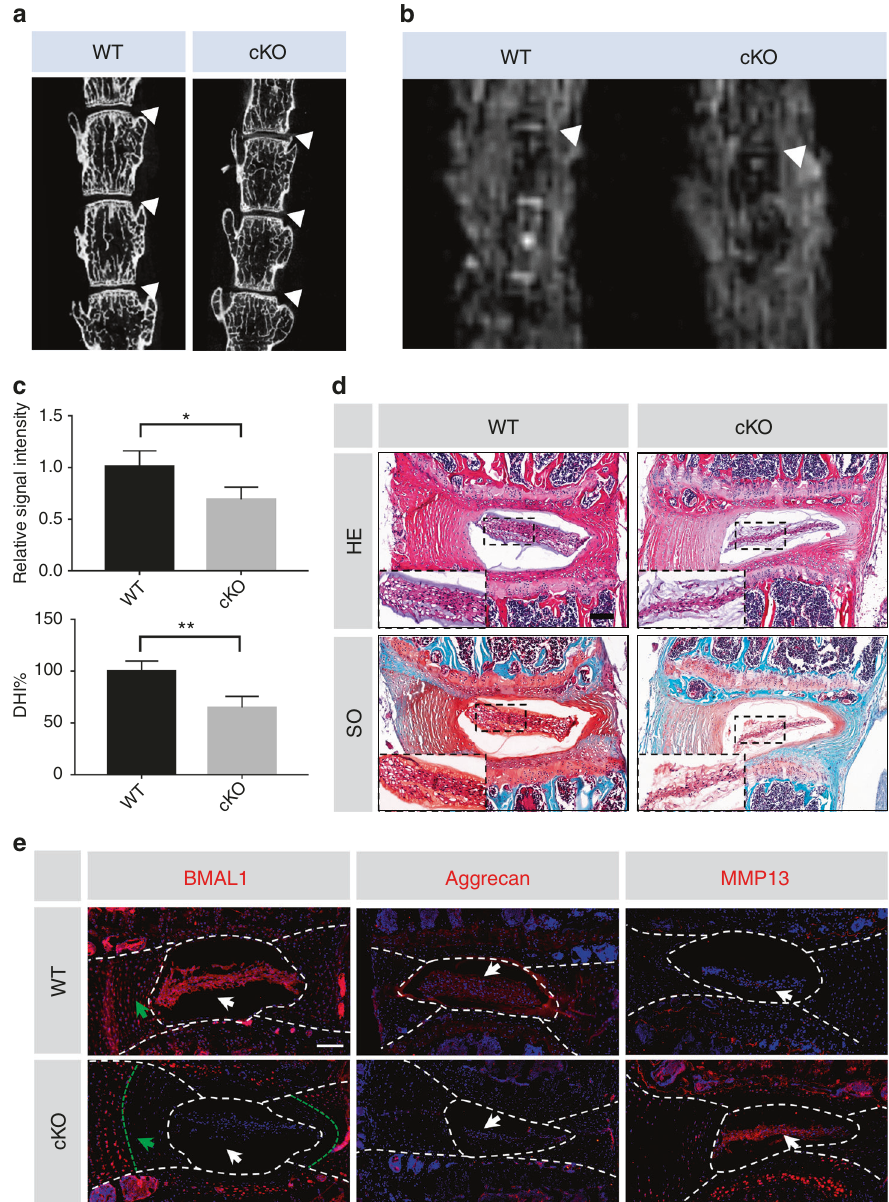
Fig. 4 Deletion of Bmal1 leads to the degradation of ECM in NP tissue. a Representative µCT scans of the lumbar spine of a WT mouse and a KO littermate (6 months). White triangles: lumbar IVDs. n = 4. b Representative MRI scan of the mouse lumbar spine. White triangles: lumbar IVDs. n = 3. c Quanti fi cation of the relative signal intensity of MRI and DHI% of µCT. Student ’ s t test. d HE and SO staining of the IVDs from the lumbar spine of a WT mouse and a KO littermate (6 months). Scale bar: 100 μ m. e Representative images of immuno fl uorescence of BMAL1, Aggrecan and MMP13. White arrows: NP tissues; green arrows: inner AF tissues. Scale bar: 100 μ m. The data in the fi gures represent the mean ± S.D. ** P < 0.01, * P <